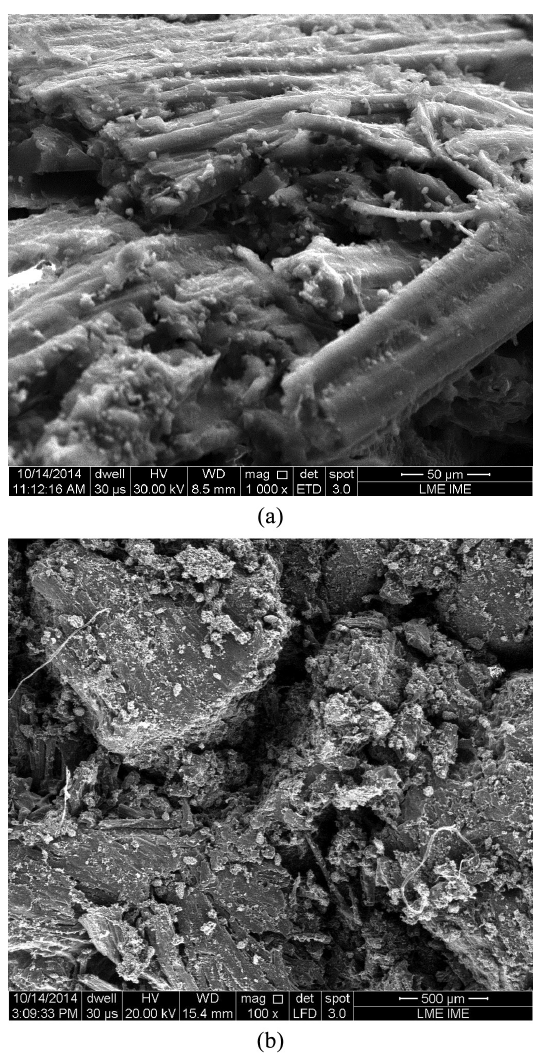
Figure 7. Fracture region of a jute fabric composite caused by fragments after the ballistic